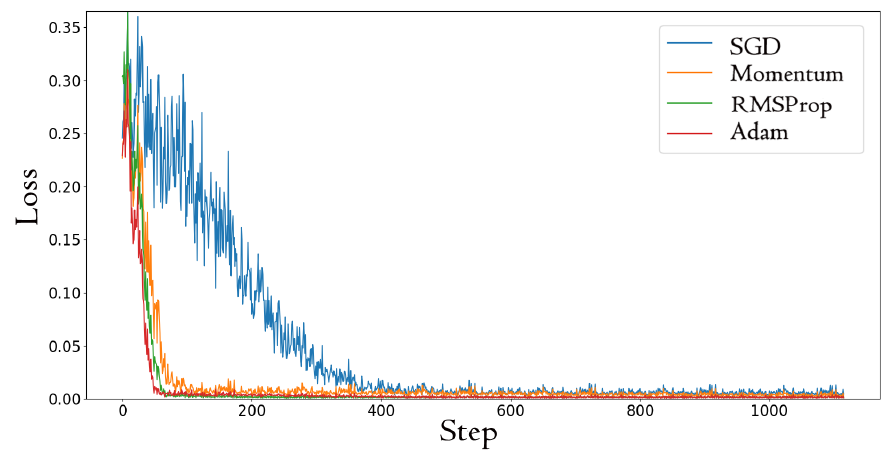
Figure 5. The MSE loss of different